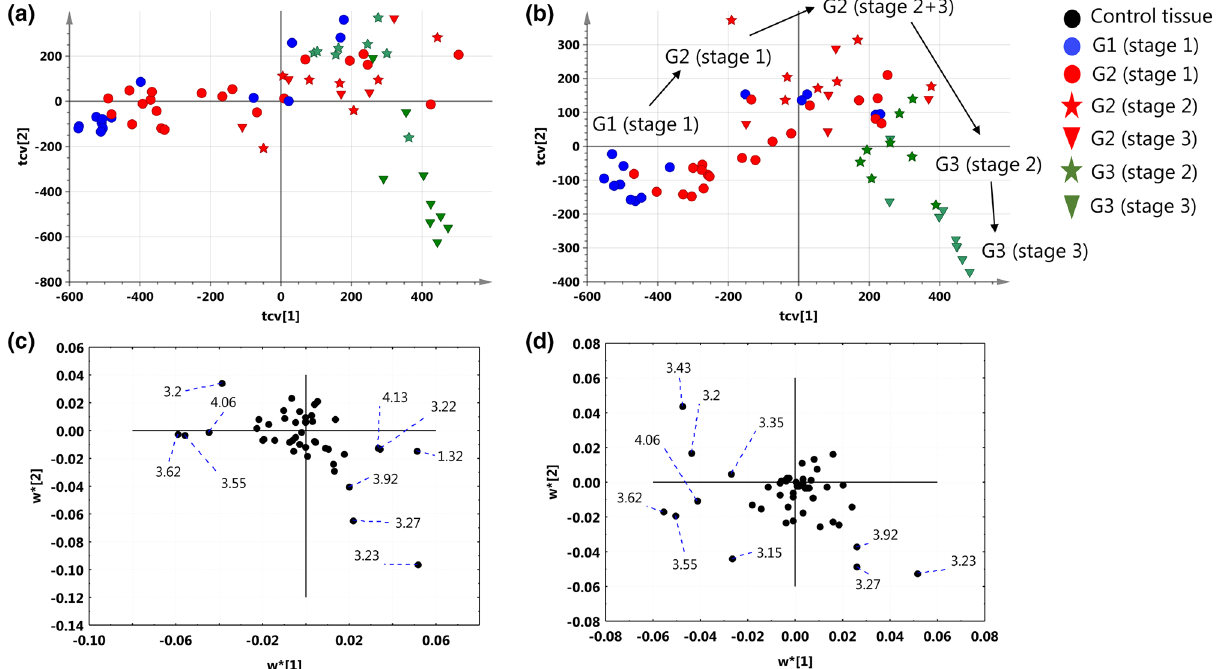
Figure 4. The cross-validated PLS-DA scores ( a ) and weights ( c ) plots obtained from the model 2 differentiating the patients according to the disease stage (2 components, R2X = 44.1%, R2Y = 44.6%, Q2 = 36.2%). The cross-validated PLS-DA scores ( b ) and weights ( d ) plots obtained from the model 3 differentiating the patients according to the tumor grade (2 components, R2X = 44.8%, R2Y = 70.4%, Q2 = 46.7%). The points in the scores plots are marked according to the disease stage and tumors grade, while the points in the weights plots are labeled according to the chemical shifts. For clarity, the most important chemical shifts are presented. The scores plots ( a , b ) were created using SIMCA-P 15.0 software package (https:// www. sarto rius. com). The weights plots ( c , d ) were created using Statistica 12.5 software (www. stats oft. pl)